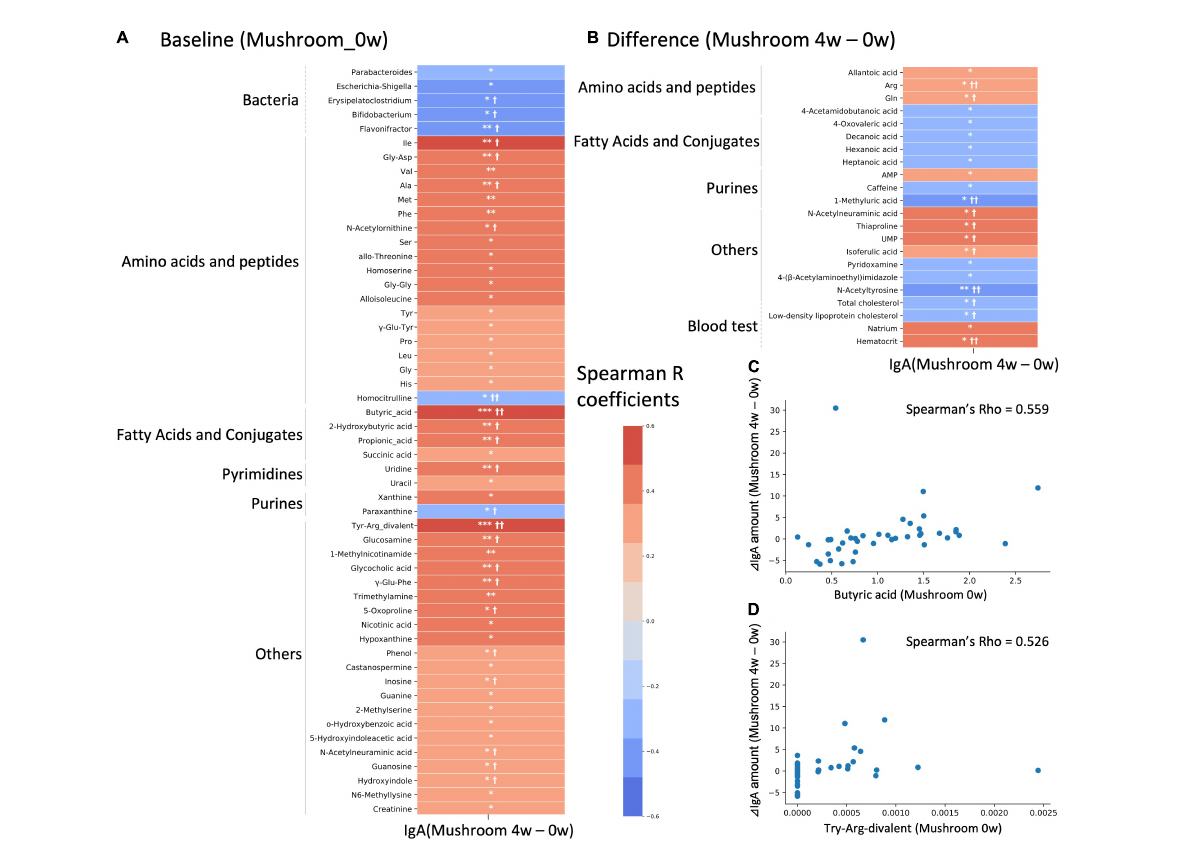
FIGURE4 Correlation analysis with intestinal immunoglobulin A (IgA). Heatmap representing the correlation of the difference in intestinal IgA content between 4-week and 0-week with either (A) baseline values; or (B) differential values of each gut microbe and metabolite abundance and blood measured item. Colors show the Spearman coefficients, and stars show Spearman coefficients’ no-correlation test ( ∗ p < 0.05; ∗∗ p < 0.01; ∗∗∗ p < 0.001). In addition, Wilcoxon rank-sum test was performed on the top 10 subjects and bottom 10 subjects based on increase in IgA level ( † p < 0.05; †† p < 0.01). (C,D) Scatter plots showing the relationship of (C) butyric acid and (D) Try-Arg-divalent to behavior of intestinal IgA